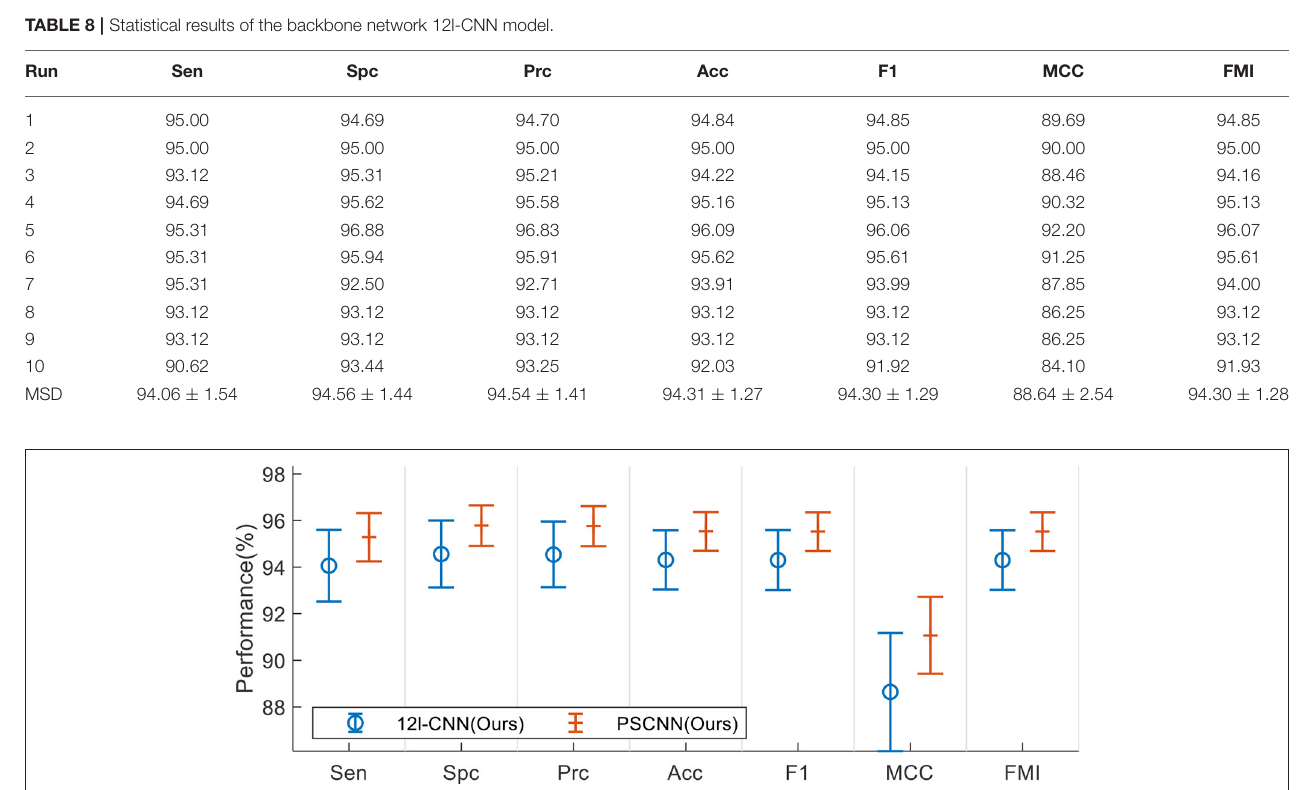
TABLE 8 | Statistical results of the backbone network 12l-CNN model.